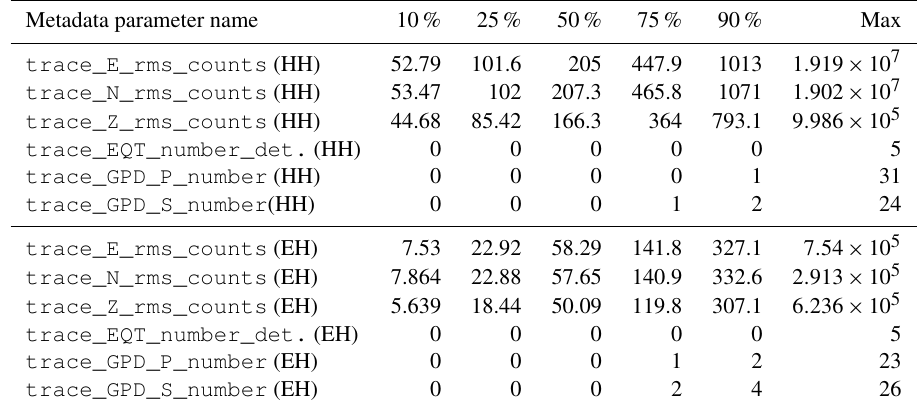
Figure 19. Histogram of the distribution of the quality control metadata of the noise E -, N -, and Z -component waveform traces: rms, min, max, and first and third quartile. The width of the bins is 2 × 10 3 . The full distribution of values is provided in Fig. D6. The horizontal axis labels correspond to the metadata being represented which are listed in Table 2. Table 5. Distribution according to different quantiles of selected noise metadata (cf. Table 2) for the HH and EH channels. Metadata parameter